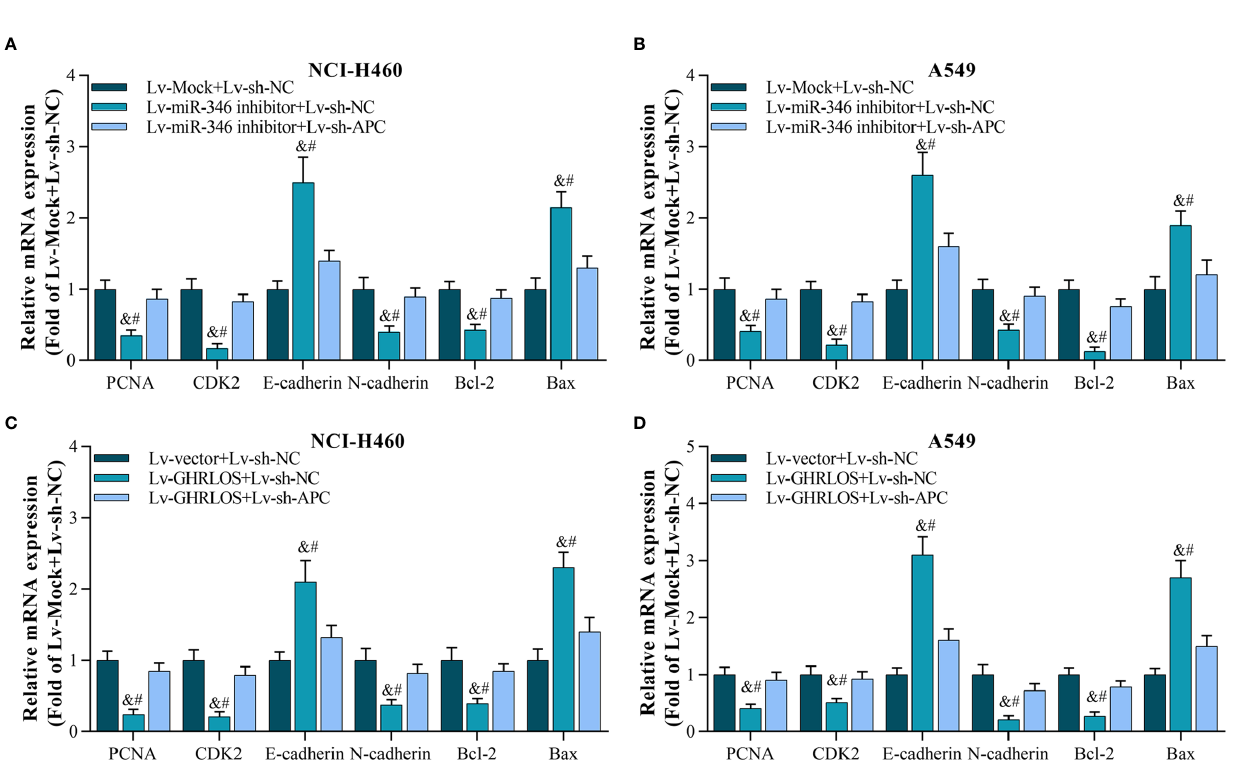
FIGURE 7 | Silencing APC blocked miR-346 knockdown- or lncRNA GHRLOS overexpression-controlled gene expression on biomarkers of cell proliferation, invasion, and apoptosis. (A, B) qRT-PCR analysis on gene expression after lentivirus infection for 48 h in A549 and NCI-H460 cells, & p < 0.01 vs. Lv-Mock+Lv-sh- NC, # p < 0.01 vs. Lv-miR-346+Lv-sh-APC. (C, D) qRT-PCR analysis on gene expression in NSCLC cells with lentivirus infection for 48 h, & p < 0.01 vs. Lv-Mock+Lv- sh-NC, # p < 0.01 vs.